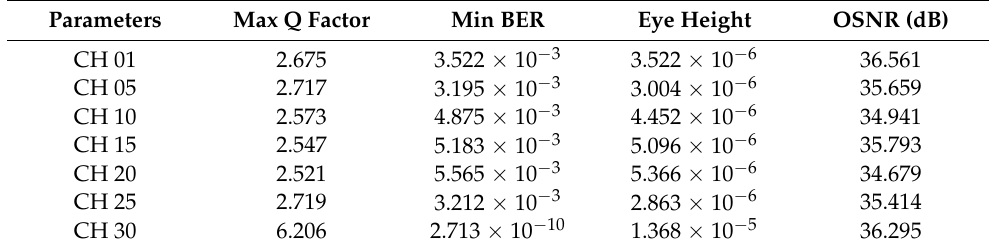
Figure 9. SOA model in our DWDM. Table 11. Results of 32-channel SOA DWDM system.